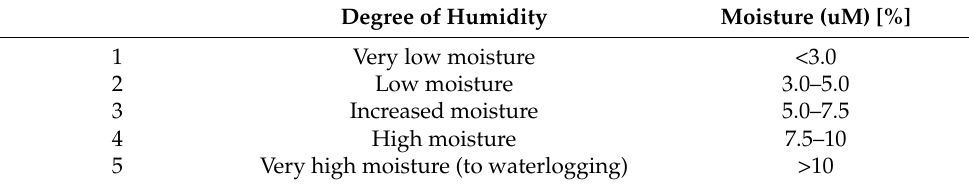
Table 1. Degree of moisture of constructions